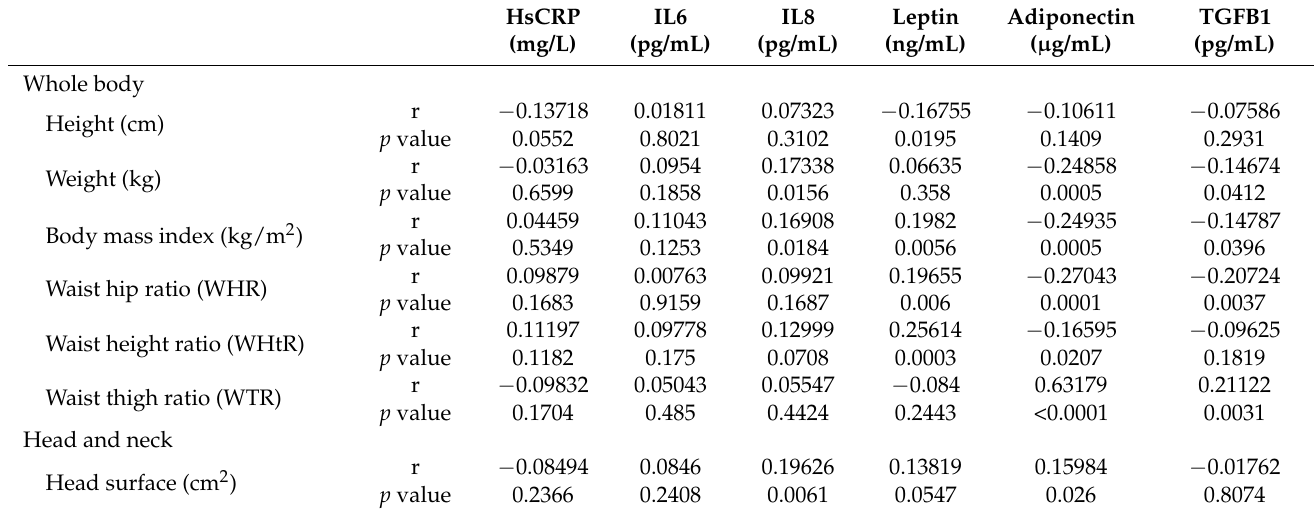
Table 4. Association between body measurements and